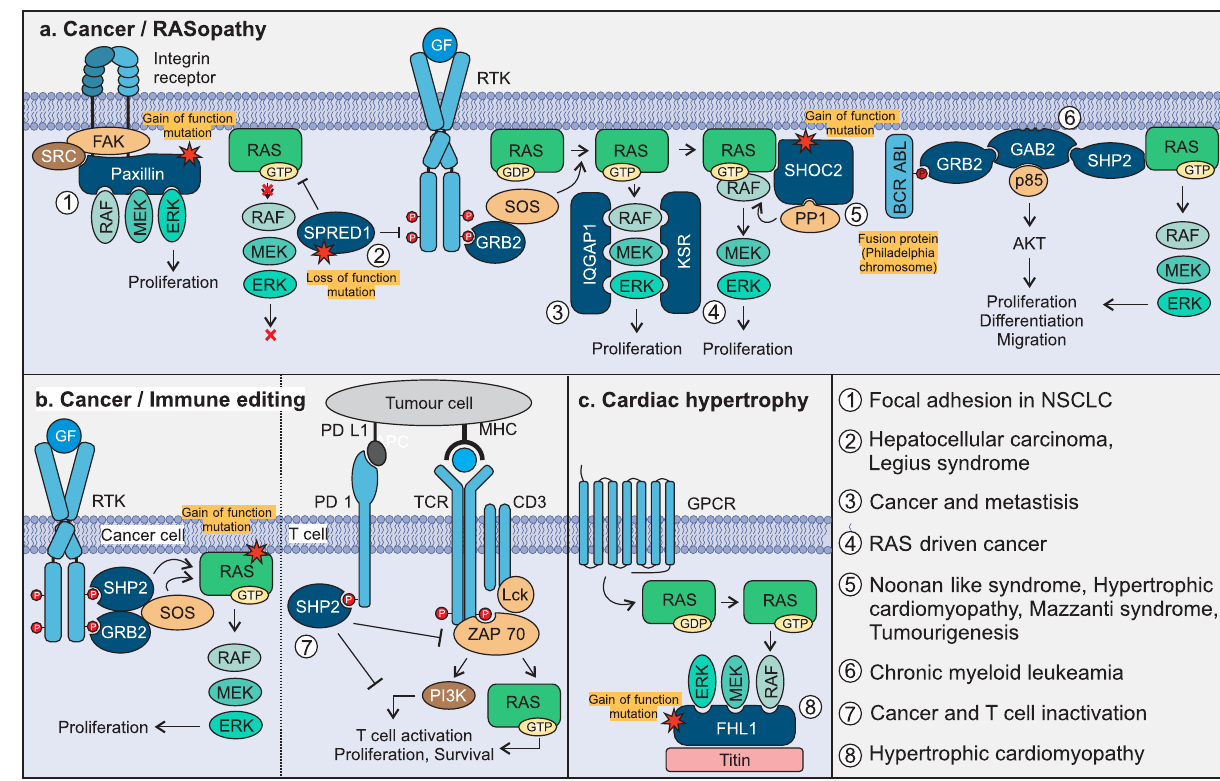
Fig. 3 Involvement of accessory proteins in diseases. The canonical RAS/MAPK pathway is tightly regulated by many proteins, attenuators and negative feedback mechanisms. Mutations in regulators like accessory proteins can lead to a dysregulated RAS/MAPK pathway and therefore to a variety of diseases as cancer and RASopathies ( a ). The genomic ampli fi cation of Paxillin is found in many NSCLC patients and activates the focal adhesion complex downstream of integrins (1). Loss-of-function mutations of SPRED1 activate the RAS-MAPK pathway and lead to Legius syndrome (germline) and hepatocellular carcinoma (somatic) (2). IQGAP1 mutations are often associated with tumour formation and metastasis (3), whereas KSR is a central player in KRAS-driven cancers, inducing proliferation and survival (4). Mild gain-of-function mutations of SHOC2 lead to Noonan-like syndrome with loose anagen hair or Mazzanti syndrome, other somatic mutations can lead to hypertrophic cardiomyopathy or tumourigenesis (5). The signalling of BCR-ABL- positive cells in chronic myeloid leukaemia is also dependent on GAB2 activation, cross-linking AKT and RAS pathway (6). The adaptor protein SHP2 is not only part of hyperactive RAS signalling in cancer cells, but is of major importance in the inactivation of T cells, inhibiting the TCR signal in response to ligand binding to PD-1 ( b ). FHL1 is involved in the development of cardiac hypertrophy, which is caused by a gain-of-function mutation, leading to increased ERK signalling ( c